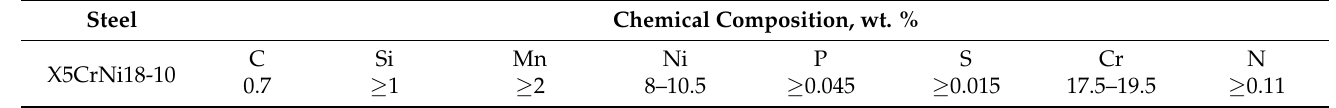
Table 5. Chemical composition of steel X5CrNi18-10 according to EN 10088-2-2005. Steel Chemical Composition, wt.